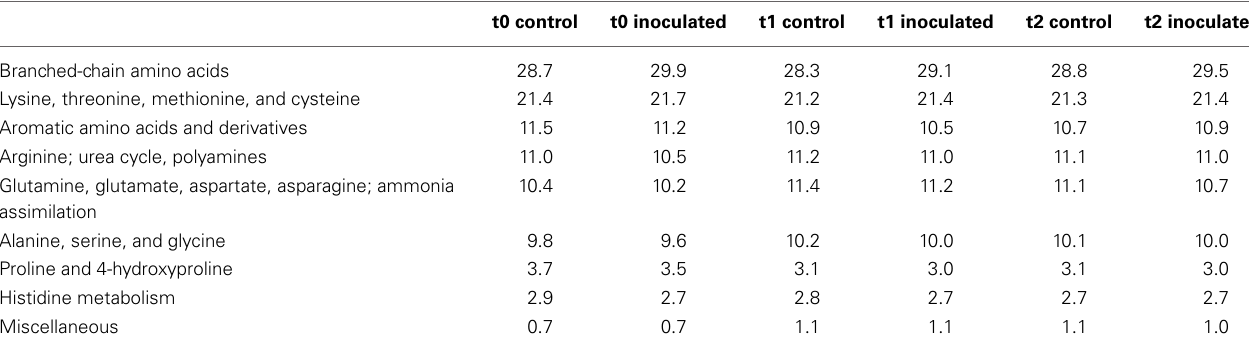
Table 10 | Relative abundances of annotated subsystems within the annotated functional system of amino acids and derivatives.